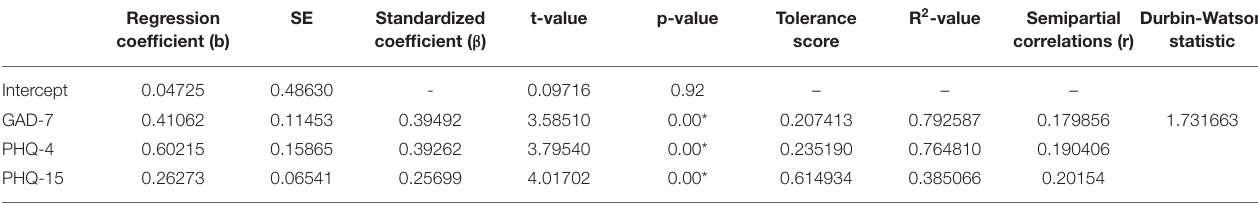
TABLE 5 | Multiple linear regression model with the PHQ-9 as the dependent variable and GAD-7, PHQ-4, and PHQ-15 as independent variables. Regression coefficient (b)